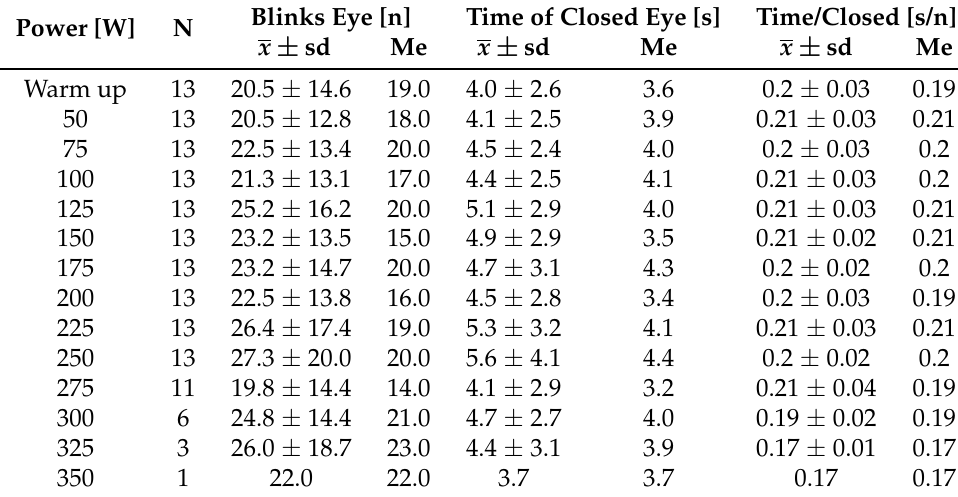
Table 2. Characteristic of analysed parameters in term of